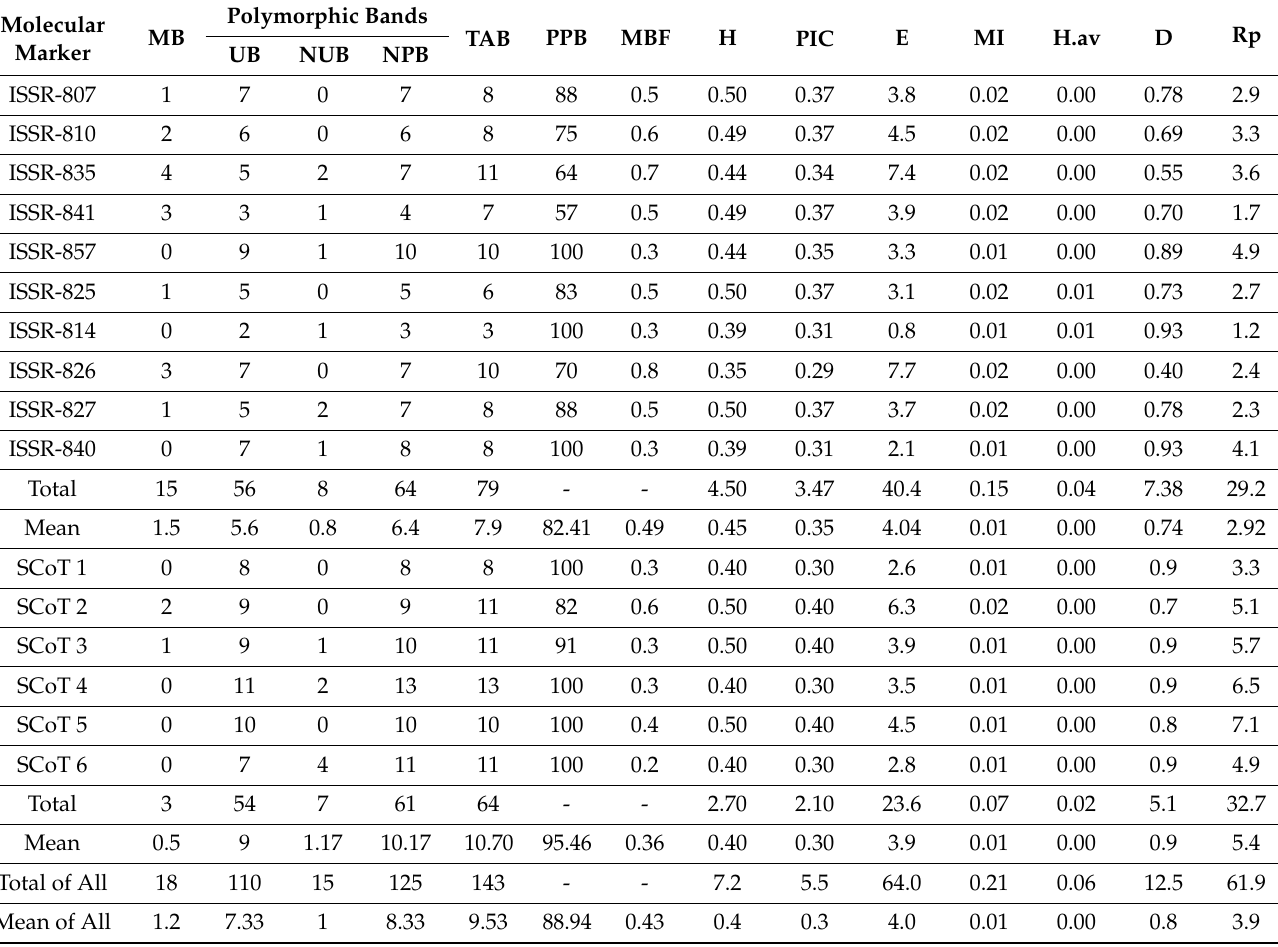
Table 6. Number of amplified bands, number of polymorphic bands, polymorphism percentage, mean of band frequency and marker efficiency calculations of the 16 ISSR and SCoT markers assayed for the 16 T. aestivum genotypes studied.